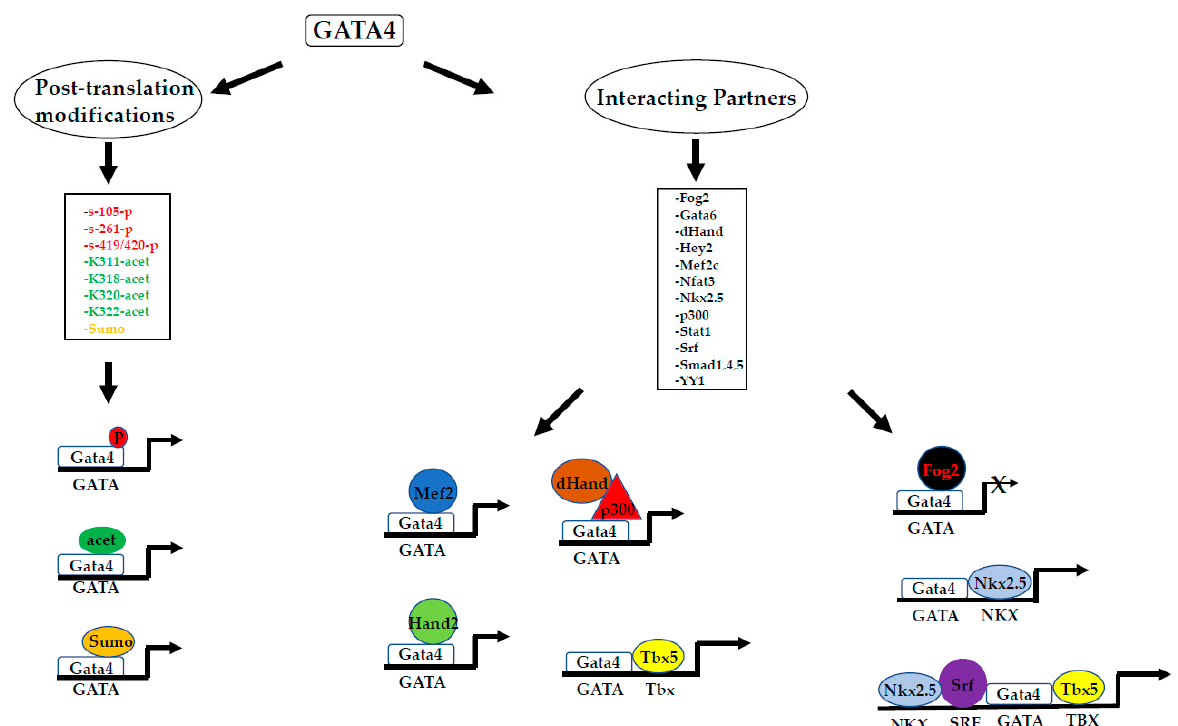
Figure 3. Schematic of cardiac transcriptional activity regulated by Gata4 with several other transcription factors showing that post-translational modifications of Gata4 is at the centre of Gene Regulatory Networks (GRNs) regulating cardiac formation and function. Abbreviations: P, Phosphorylation; Acet, Acetylation; Sumo, SUMOylation.